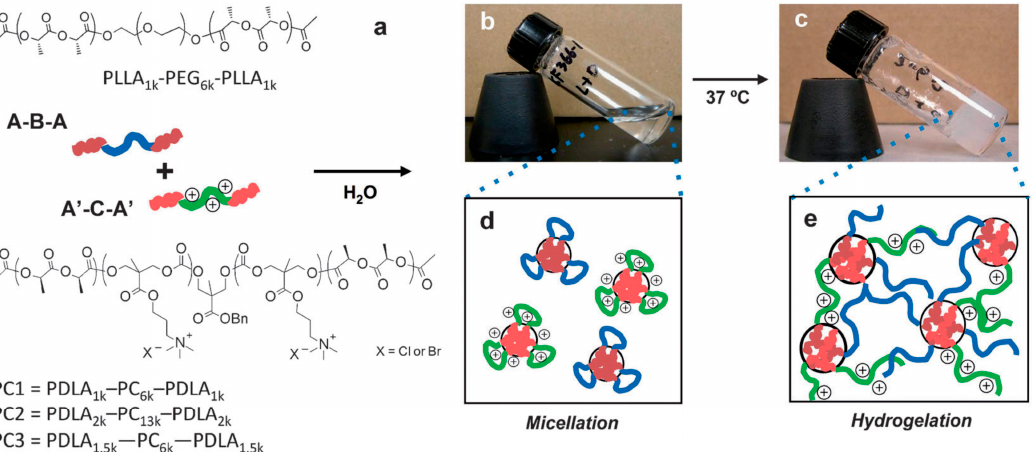
Figure 11. Chemical structures of the mixed micelle solution containing poly( L -lactide)- b -poly(ethylene glycol)- b -poly( L -lactide) (PLLA-PEG-PLLA) and poly(carbonate)- b -poly( D -lactide) (PDLA-CPC-PDLA). Schematic illustration ( a ) and pictures of 10% w / v solution at 25 ◦ C ( b ) and at 37 ◦ C ( c ). At 25 ◦ C, the solution is a clear fluid, and each polymer forms flower-type micelles in an aqueous environment ( d ). Upon heating at 37 ◦ C for 30 min, the solution turns into an opaque gel based on stereocomplex formation between enantiomeric pure polylactide segments in the micelle cores ( e ). Reproduced with permission from [41].